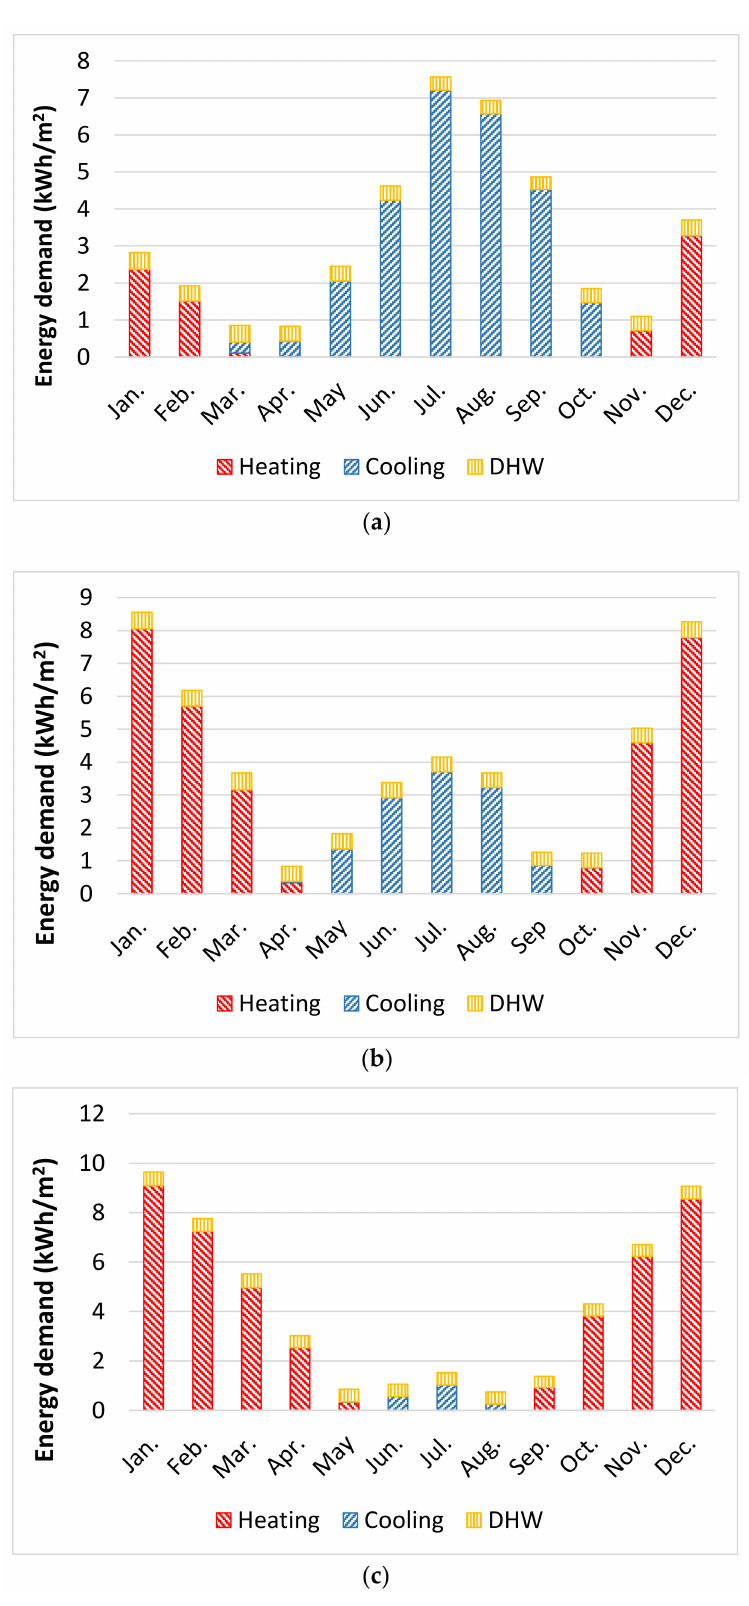
Figure 4. Monthly energy needs for heating, cooling and domestic hot water (DHW) of office buildings located in Madrid ( a ), Berlin ( b ) and Helsinki ( c